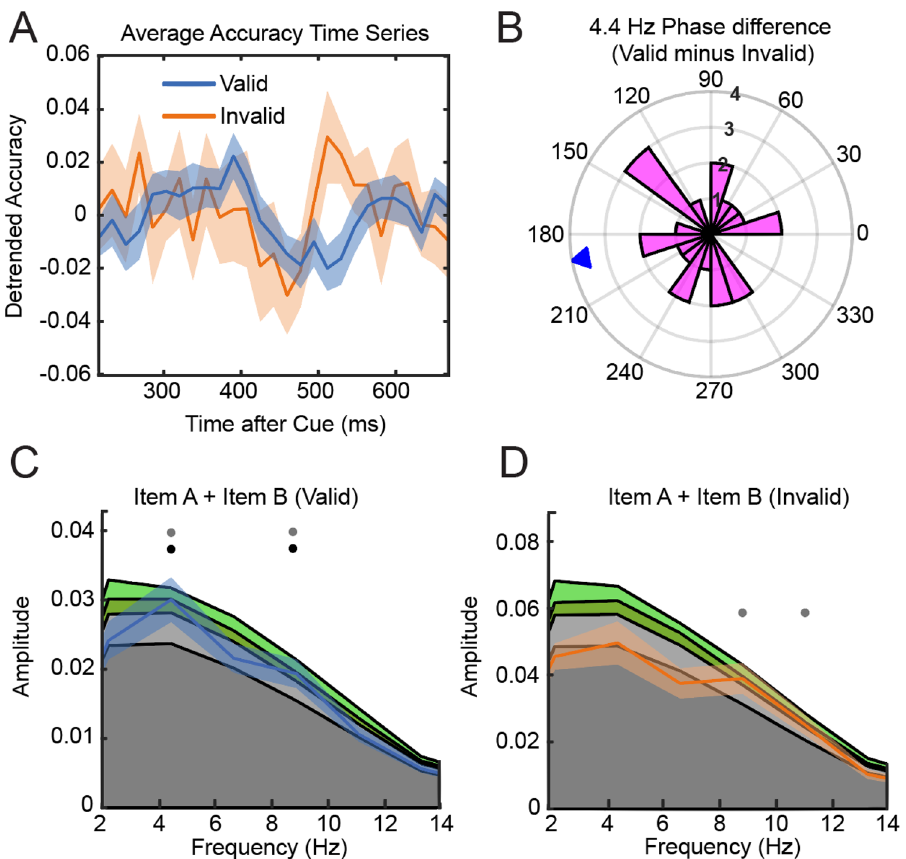
Figure 6. ( A ) Group average accuracy time series for valid and invalid trials. ( B ) 4.4 Hz Phase difference plot. ( C ) Power-spectrum accuracy time series valid condition. Colored areas (dark grey: mean of permutation distribution, light grey < 95% confidence interval, green < 99% confidence interval). ( D ) same as C but accuracy time series of Invalid condition. Dots indicate frequencies at which observed spectrum exceeded 95% of samples from permutation distribution (gray: significant before correction for multiple comparisons, black: significant after correction of multiple